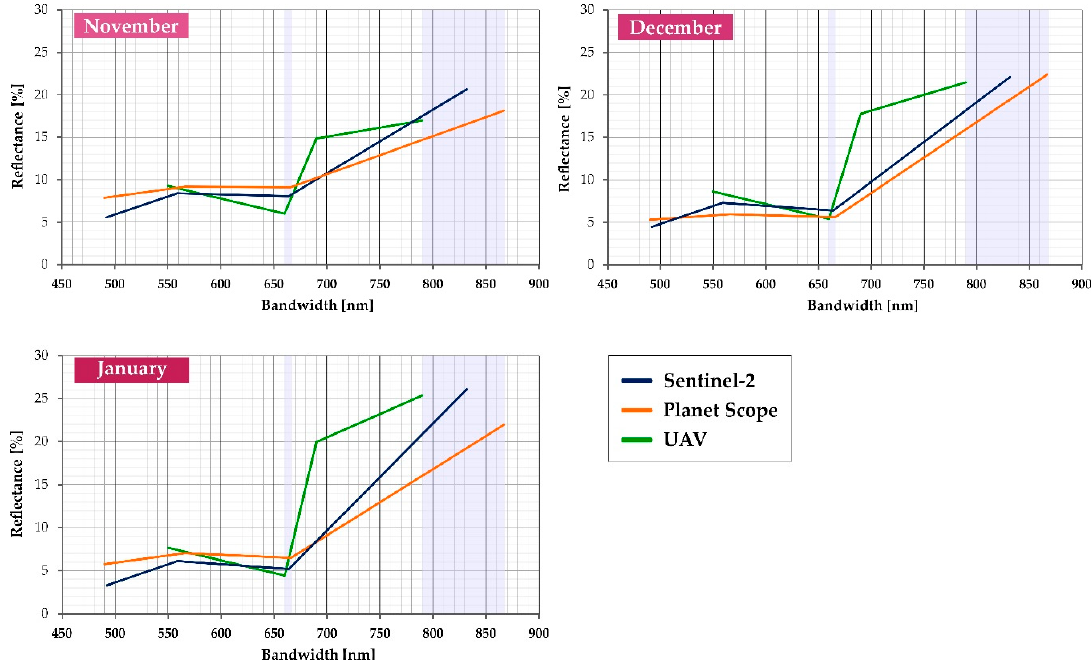
Figure A1. The spectral signature of onion crop derived from the reflectance data of pure onion pixels for the three platforms in the three periods surveyed (November, December, and January). The shaded light violet indicates the region of the two bands used for the soil adjusted vegetation index (SAVI) calculation (red and near-infrared, NIR).